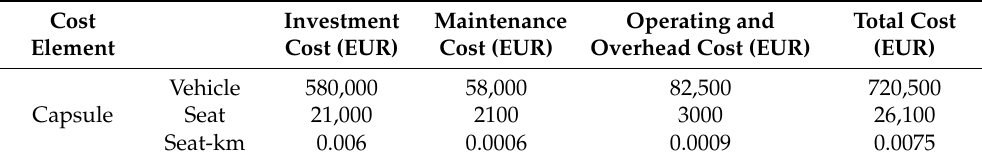
Table 4. Analysis of passenger capacity for different capsule sizes